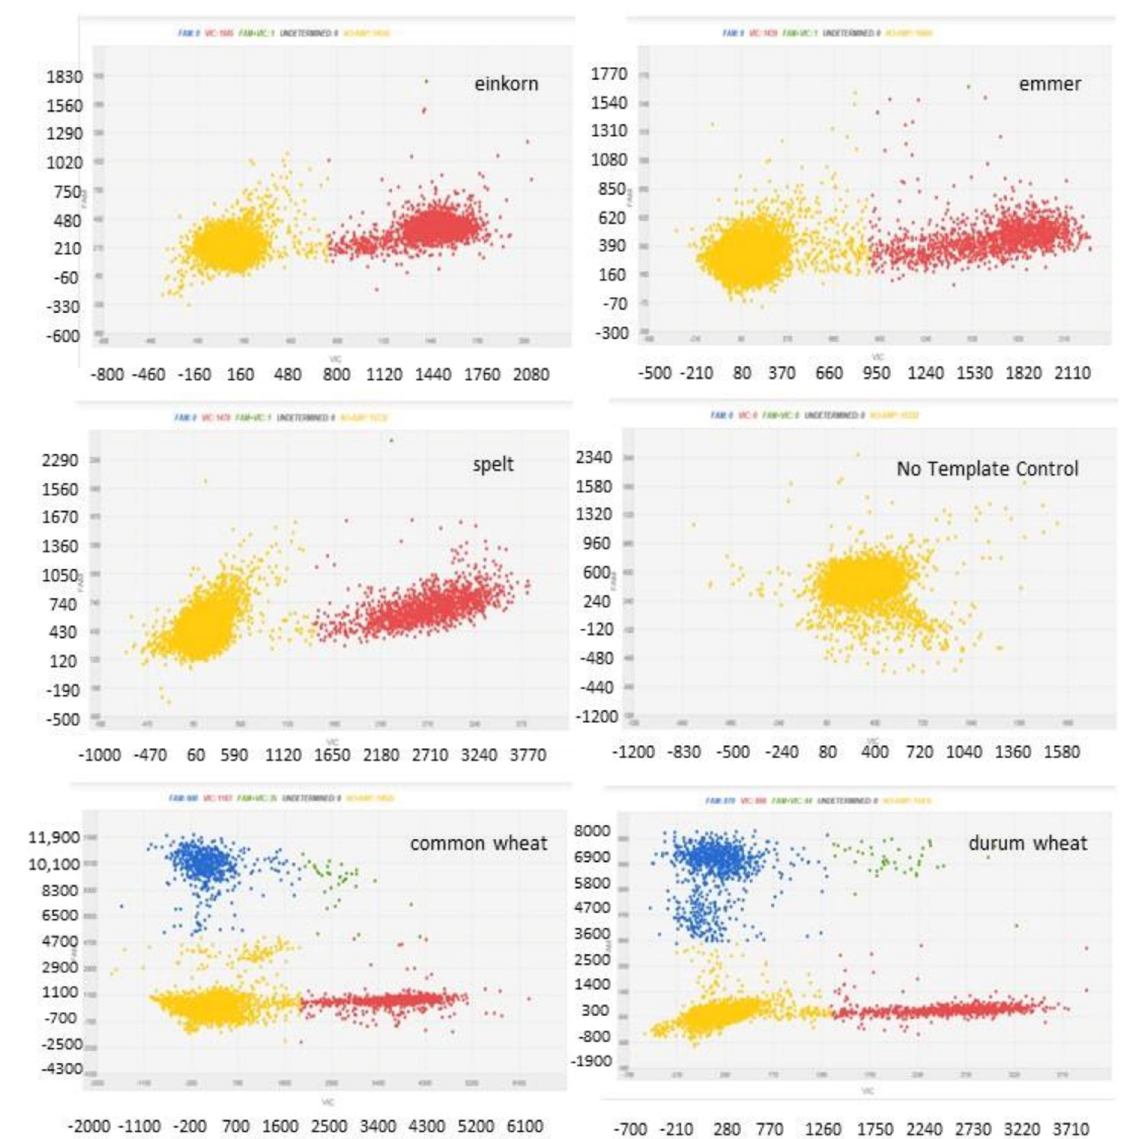
Figure 2. Two-dimensional scatter graphs generated by chip digital PCR (cdPCR) analysis of 100% hulled and hulless wheats. No template control is a blank sample without DNA, with negative partitions that contain no amplified targets (yellow signals). X axis stands for the VIC signal, whereas Y axis stands for the FAM signal. Einkorn, emmer and spelt carrying the recessive alleles show red (VIC) signal only, whereas hulless wheats, carrying both recessive and dominant alleles, show both red (VIC) and blue (FAM) signals. Green signals stand for partitions in which a co-amplification of both VIC and FAM targets